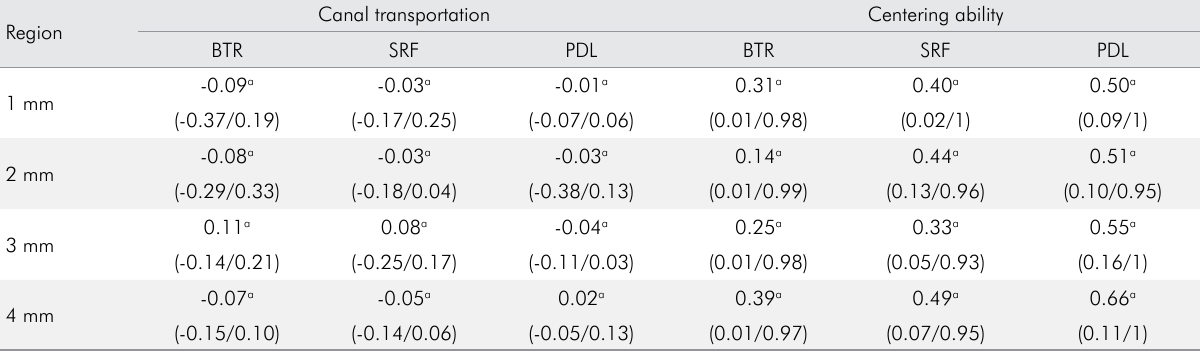
Table 2. Mean, minimum and maximum values, in mm 3 , for canal transportation and centering ability after the use of different rotary systems.